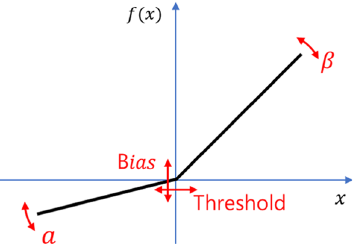
Fig. 2 Illustration of the